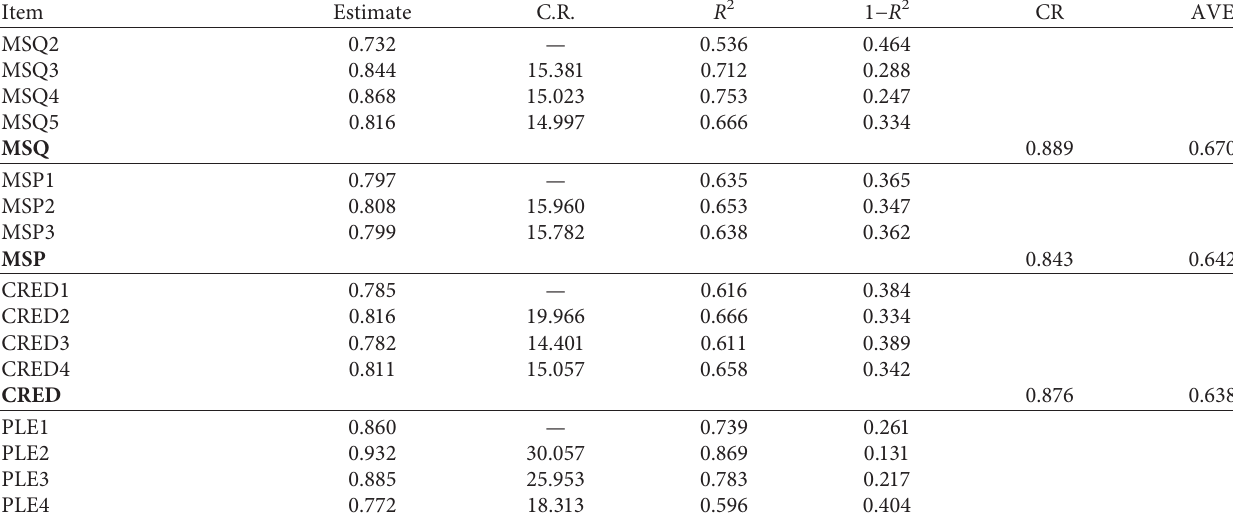
Table 4: The results of the validity